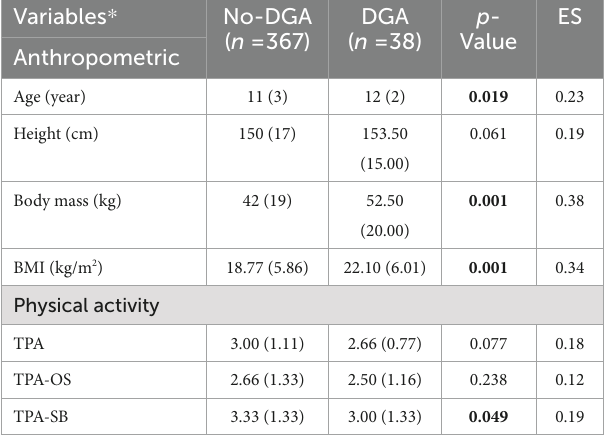
TABLE 3 Results of anthropometric variables, physical activity and digital game addiction scores according to game addiction. Variables